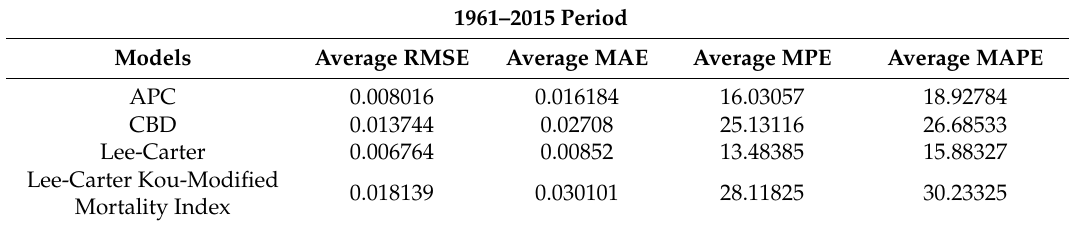
Table 2. Comparison of accuracy measures for the four models under consideration for the 1961–2015